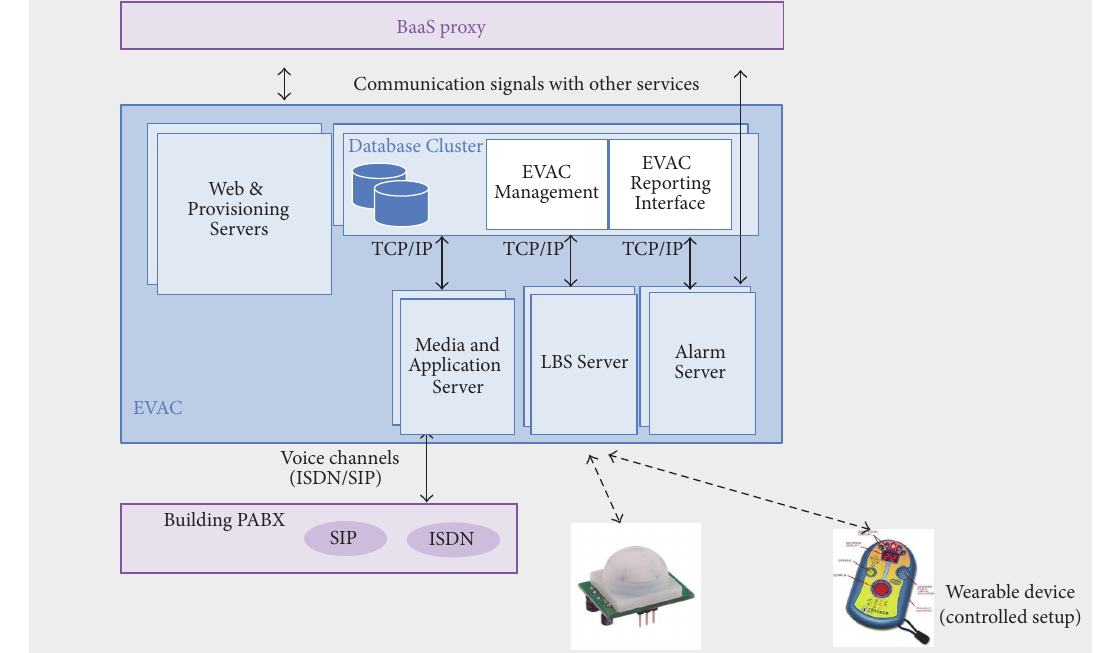
Figure 1: The block diagram of the Evacuation